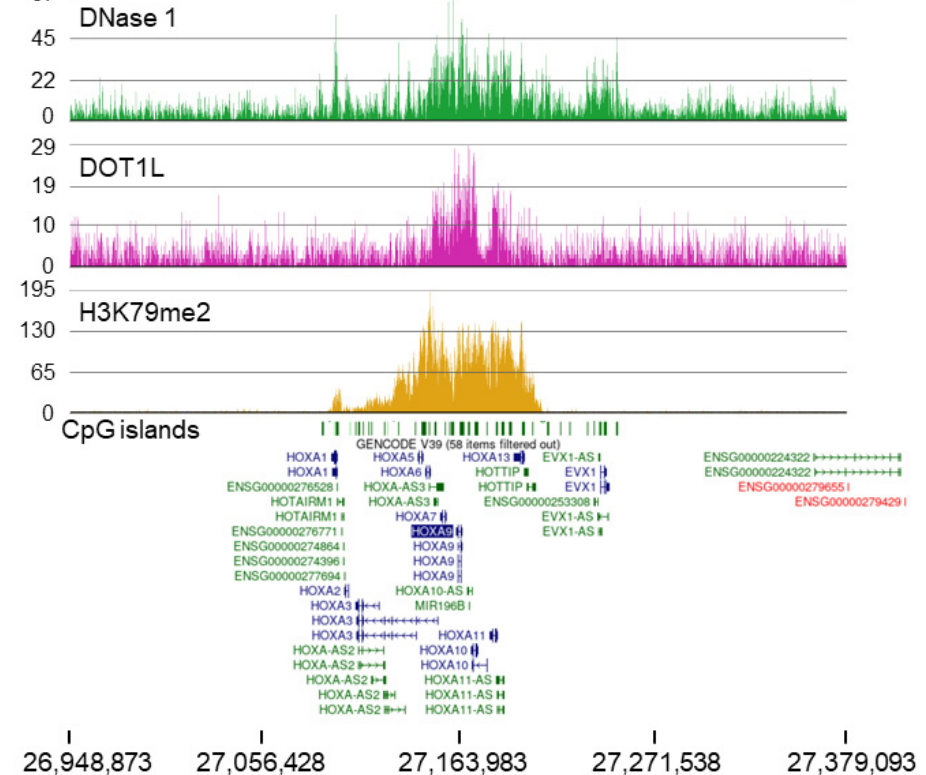
Figure 4. Broad H3K79me2 domain with the HOXA9 gene in MOLM-13 cells. ChIP-Seq tracks for DOT1L and H3K79me2 are shown. The DNase 1-Seq track shows the chromatin accessibility of the broad H3K79me2 domain with the HOXA9 gene in MOLM-13 cells. Through the CXXC domain, KMT2A-AF9 could be recruited to the numerous CpG islands present in this genomic region. KMT2A-AF9 recruits DOT1L, which methylates H3K79.